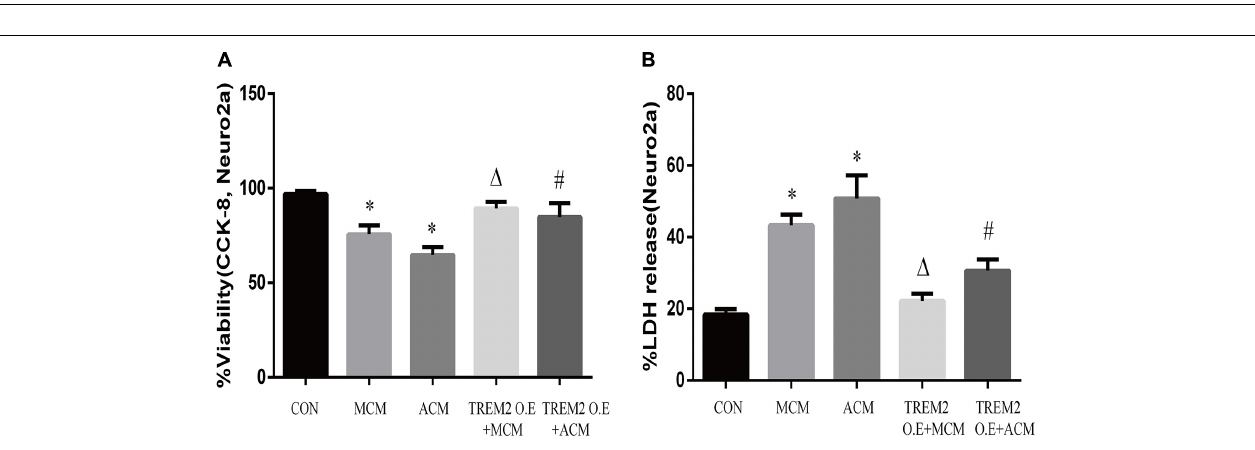
FIGURE 11 | After incubation with MCM or TREM2 overexpression + MCM for 24 h, the astrocytes were subjected to immunofluorescent staining with anti-GFAP (green), A1 anti-C3 (red; A ), anti-AQP4 (red; B ), and DAPI (blue) (immunofluorescence, × 40, scale bar = 10 µ m).